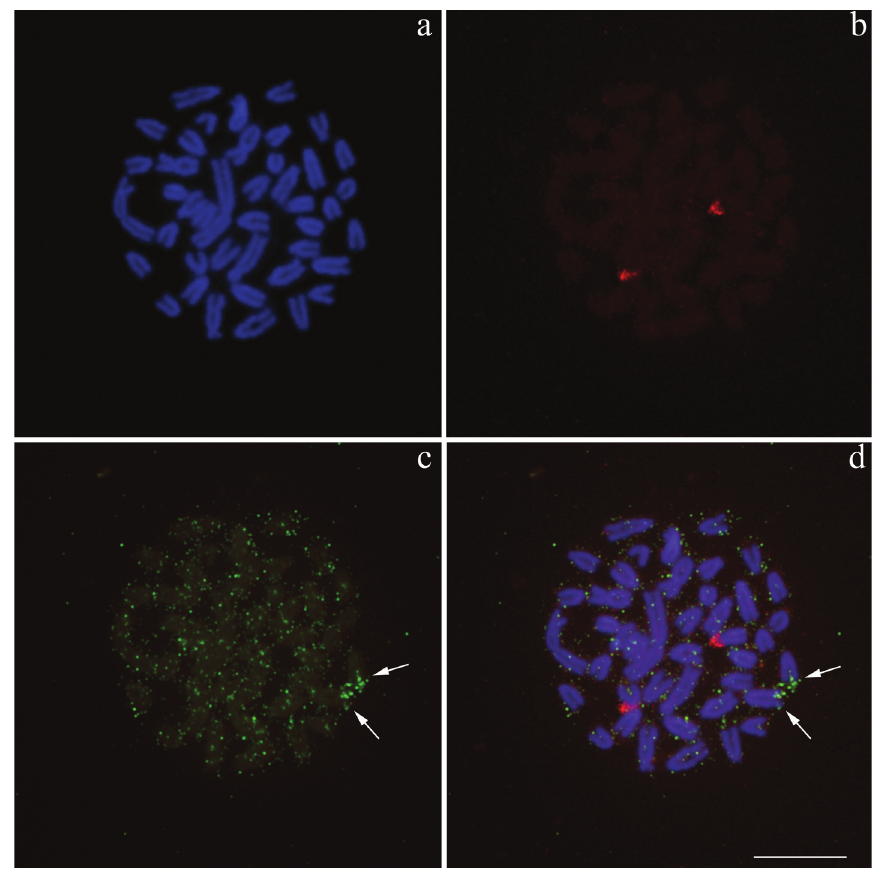
Figure 3 - Karyomorph A metaphase (a) evidencing the 18S rDNA (b) and H3 histone gene (c) hybridization patterns; (d) DAPI-stained metaphase with overlapping images of the 18S rDNA and H3 histone gene. Arrows indicate the histone site clustering in the acrocentric pair. Bar = 10 (cid:2)